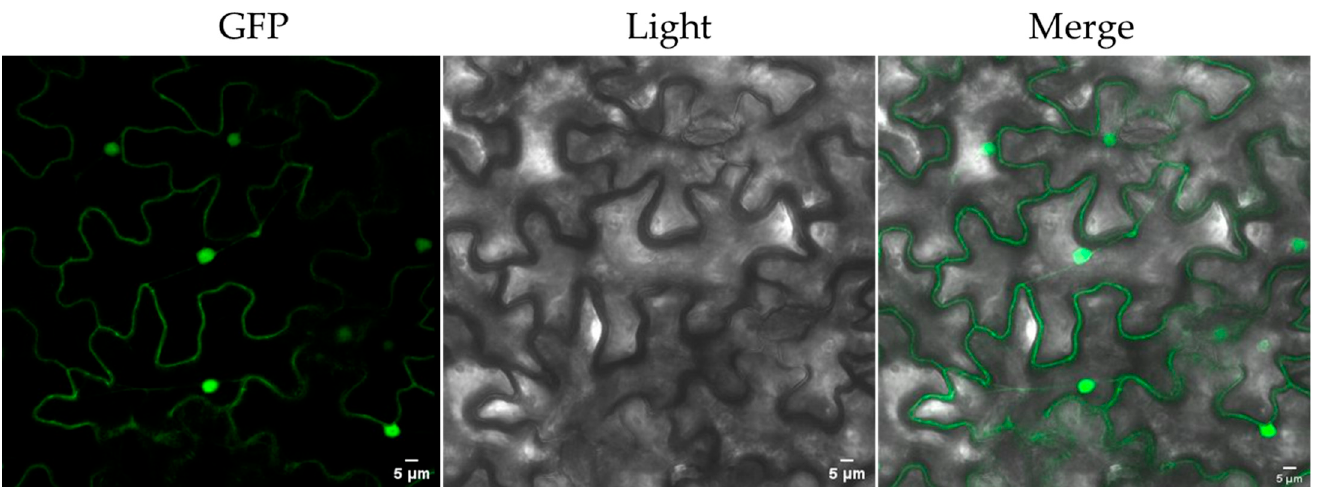
Figure 8. Subcellular localization of the PCL protein in the leaf epidermal leaf cells of a transgenic tobacco plant. Images obtained by Leica confocal microscopy. GFP: GFP fluorescence under green light; Light: visible light image; Merge: merged images.